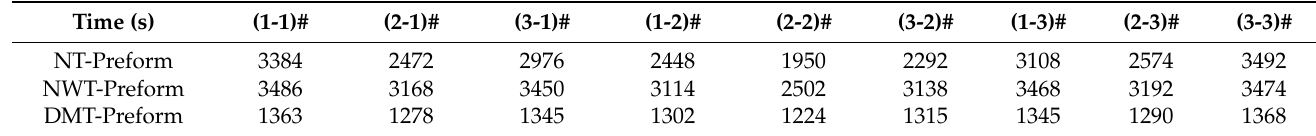
Table 2. Efflux time of resin through each